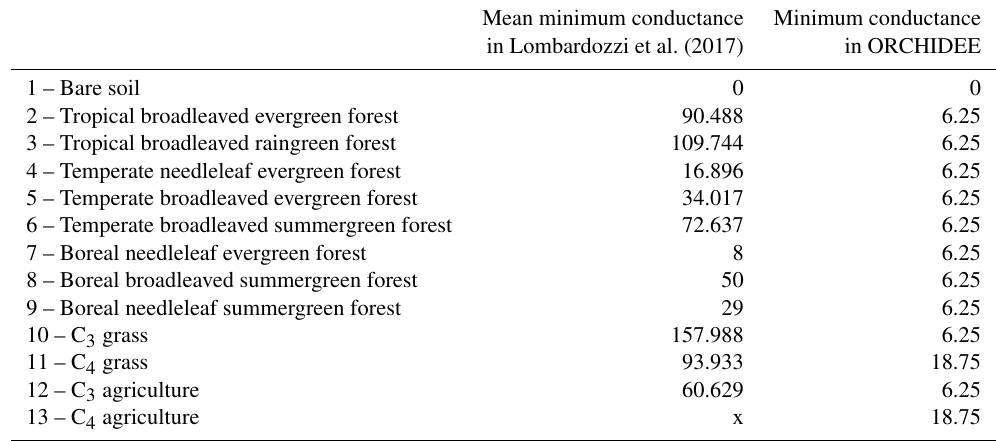
Table A3. Minimum stomatal conductance to CO 2 (mmolm − 2 s − 1 ) for each PFT in Lombardozzi et al. (2017) and ORCHIDEE. No value is given for C 4 crops in Lombardozzi et al.